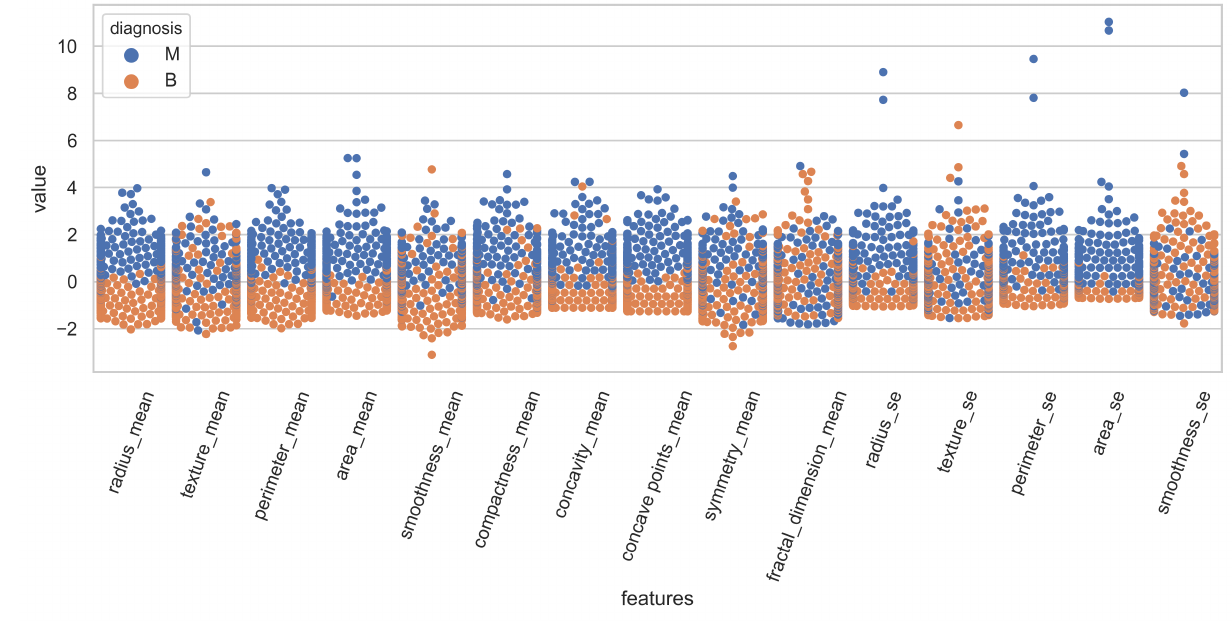
Figure 1. Representation of attributes 1–15 with respect to classes.